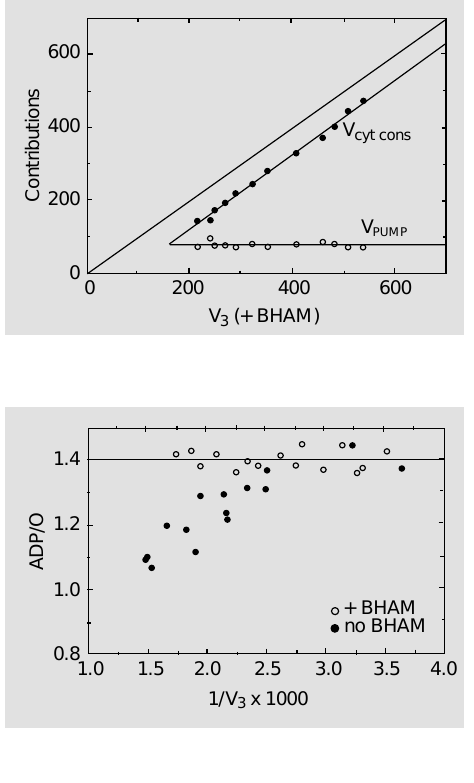
Figure 8 - Contributions of AOX activity and cytochrome pathway activity to state 3 respiration. Contributions are calculated ac- cording to equations described in the text. V alt is the alternative pathway contribution, and V cyt is the cytochrome pathway contri- bution. ADP/O and V 3 are meas- ured with succinate plus rote- none as oxidizable substrate in the presence of 0.5% BSA and 1 mM GTP. V 3 (expressed as nmol O min -1 mg protein -1 ) was de- creased by increasing concentra- tions of n-butyl